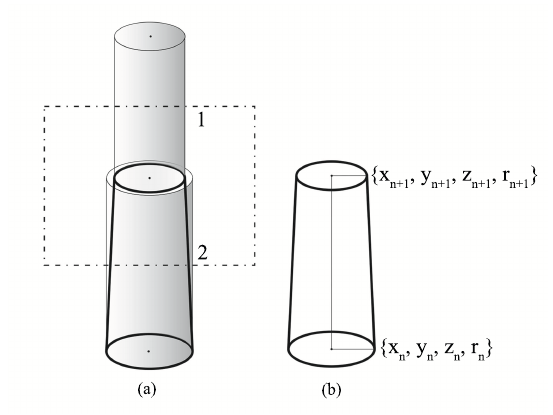
Figure 9. ( a ) A moving window technique to smooth the connection part of two consecutive cylinders; ( b ) After smoothing, a truncated cone is